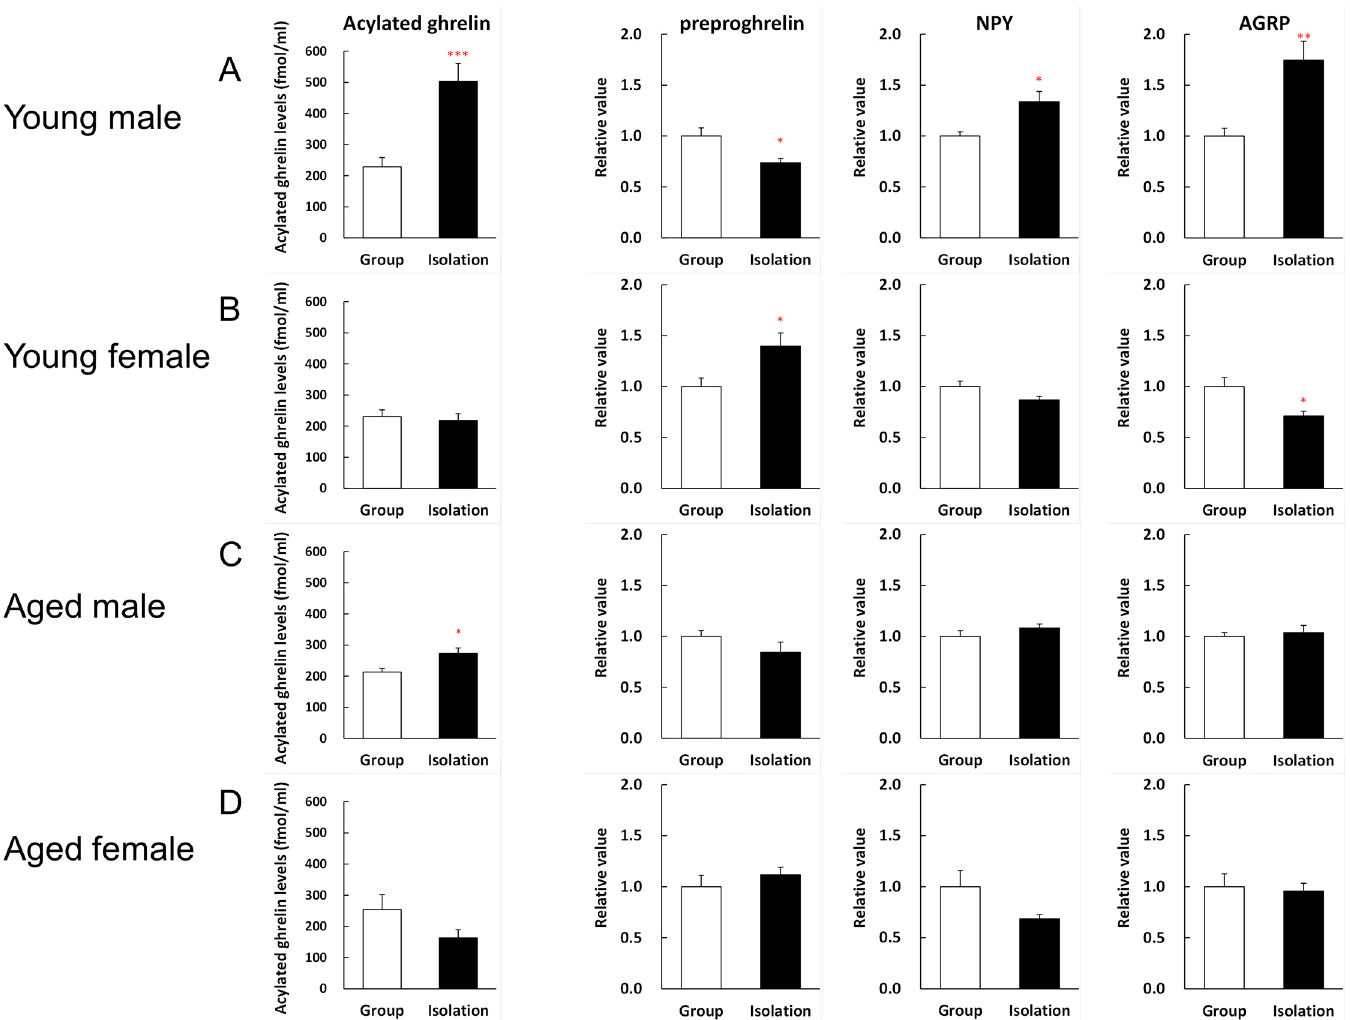
Fig 4. Changes in the plasma acylated ghrelin levels and hypothalamic gene expression levels. After 1 week of isolation, the mice were fasted for 18 h. The plasma acylated ghrelin levels and hypothalamic gene expression levels in young male mice (A), young female mice (B), aged male mice (C), and aged female mice (D) are shown. The data represent the mean ± SEM (Young group: n = 7 – 8, Young isolation: n = 8, Aged group: n = 4 – 5, Aged isolation: n = 7 – 8). * , ** , *** , p < 0.05, 0.01, 0.001 respectively vs. group-housed